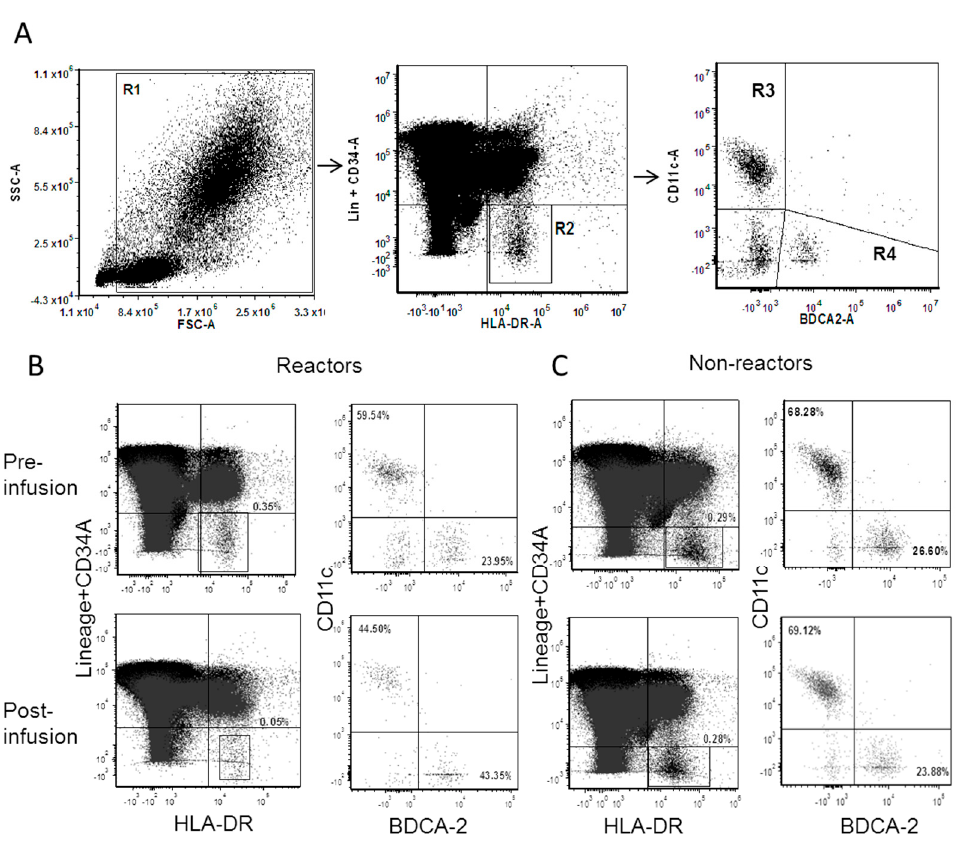
Figure 1. Flow cytometric analysis to detect dendritic cells (DCs) from peripheral blood: the figures are representative of typical patients. ( A ) R1 selects for white blood cells (WBCs). Dendritic cells are detected in R2 as the population of Lin − CD34 − / HLA-DR + and divided into Myeloid DCs − CD11c + BDCA2 − (R3), and plasmacytoid DCs − CD11c − BDCA2 + (R4). ( B , C ) Representative DCs, myeloid DCs and plasmacytoid DCs from Fabry disease (FD) patients with IRRs and no IRRs, respectively.